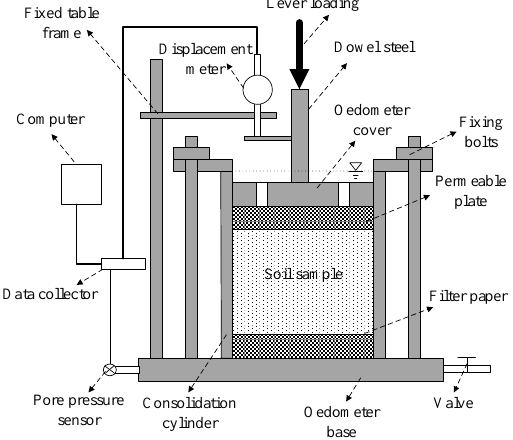
Figure 5. Schematic diagram of the improved oedometer. Table 3. Basic properties of the rheological consolidation test sample.